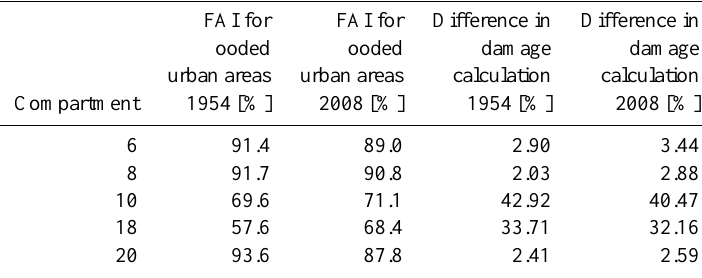
Table 2. Comparison between the quasi-2-D and fully-2-D models for the flooded compartments of interest. FAI for FAI for Difference in Difference in flooded flooded damage damage urban areas urban areas calculation calculation Compartment 1954 [%] 2008 [%] 1954